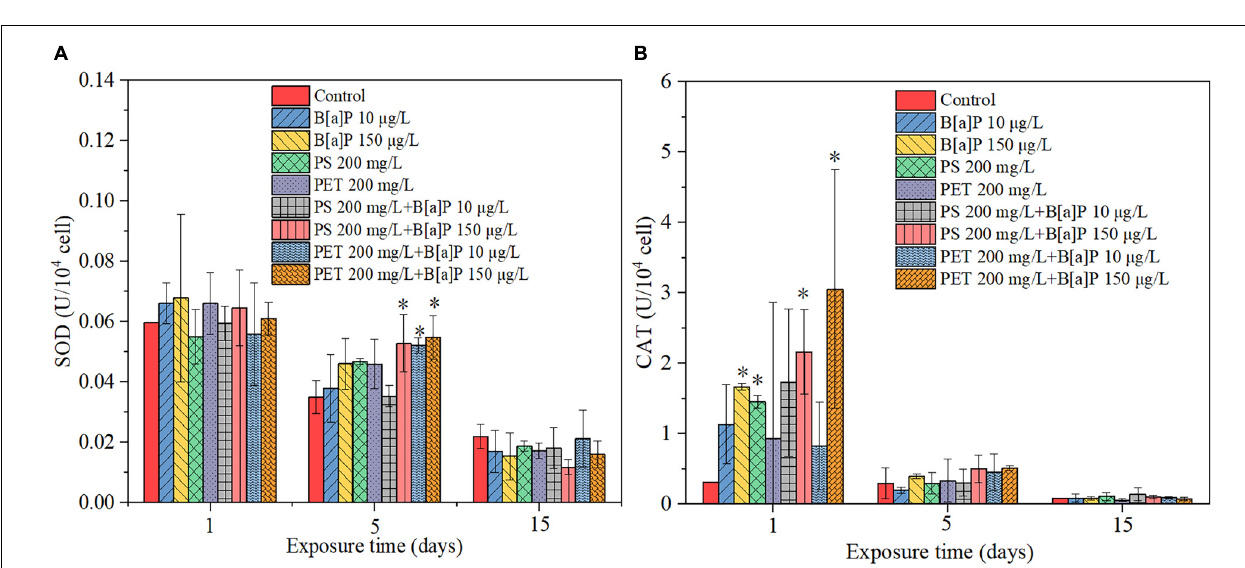
FIGURE 5 | The single and combined effects of microplastics (mPS and mPET) and B[a]P on the photosynthetic pigment of C. muelleri in (A) day 1, (B) day 5, and (C) day 15.